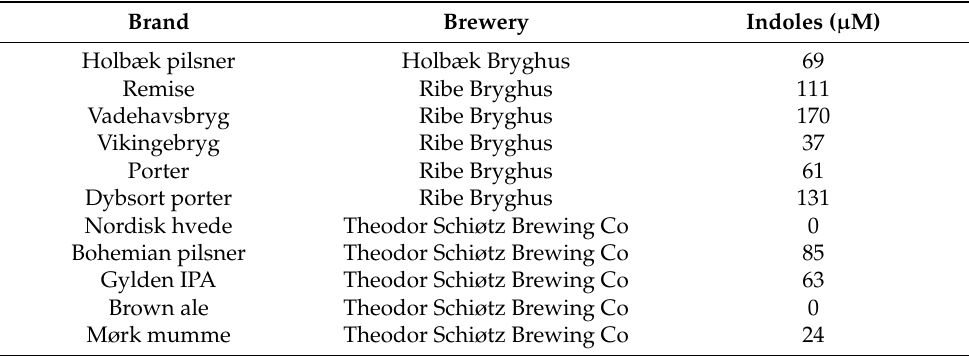
Table 3. Quantitative estimate of indoles in Danish beers based on NMR.